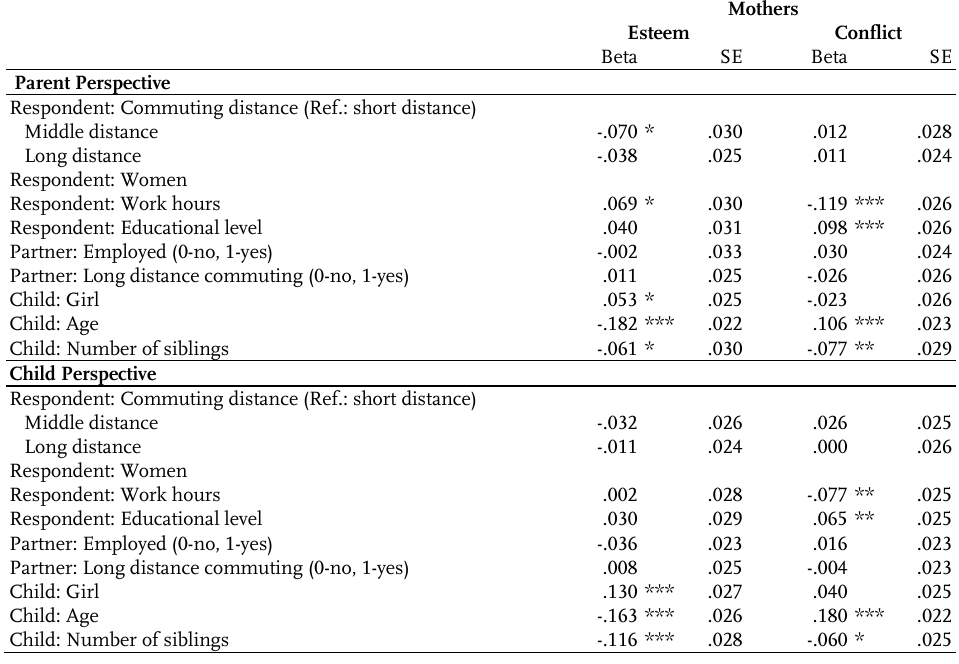
Mothers Esteem Conflict Beta SE Beta SE